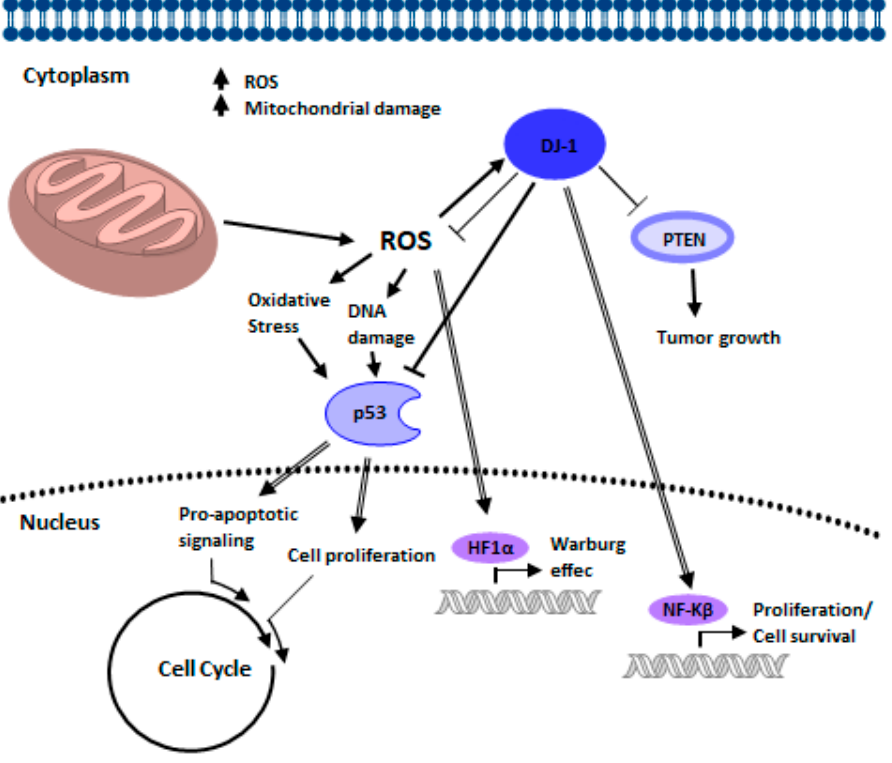
Figure 3. Graphical representation of the interactions of the PINK proteins. The directionality and the nature of the interactions (activation or inhibition) are shown as they are believed to exist in a healthy state.